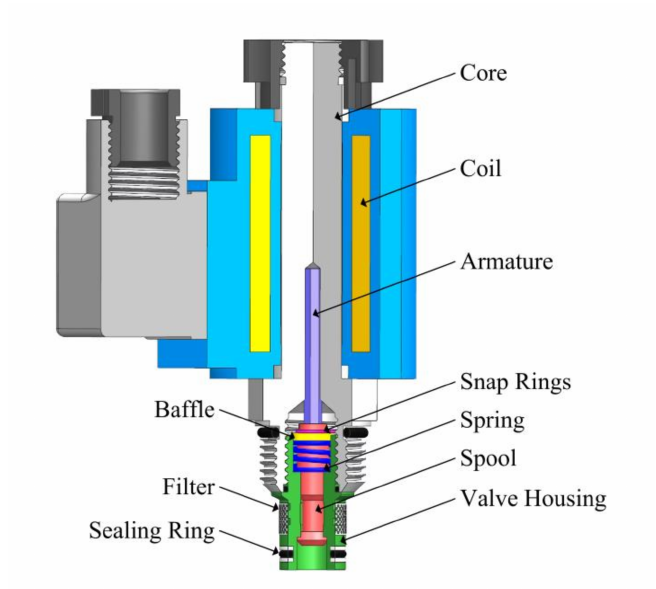
Figure 1. Valve configuration.